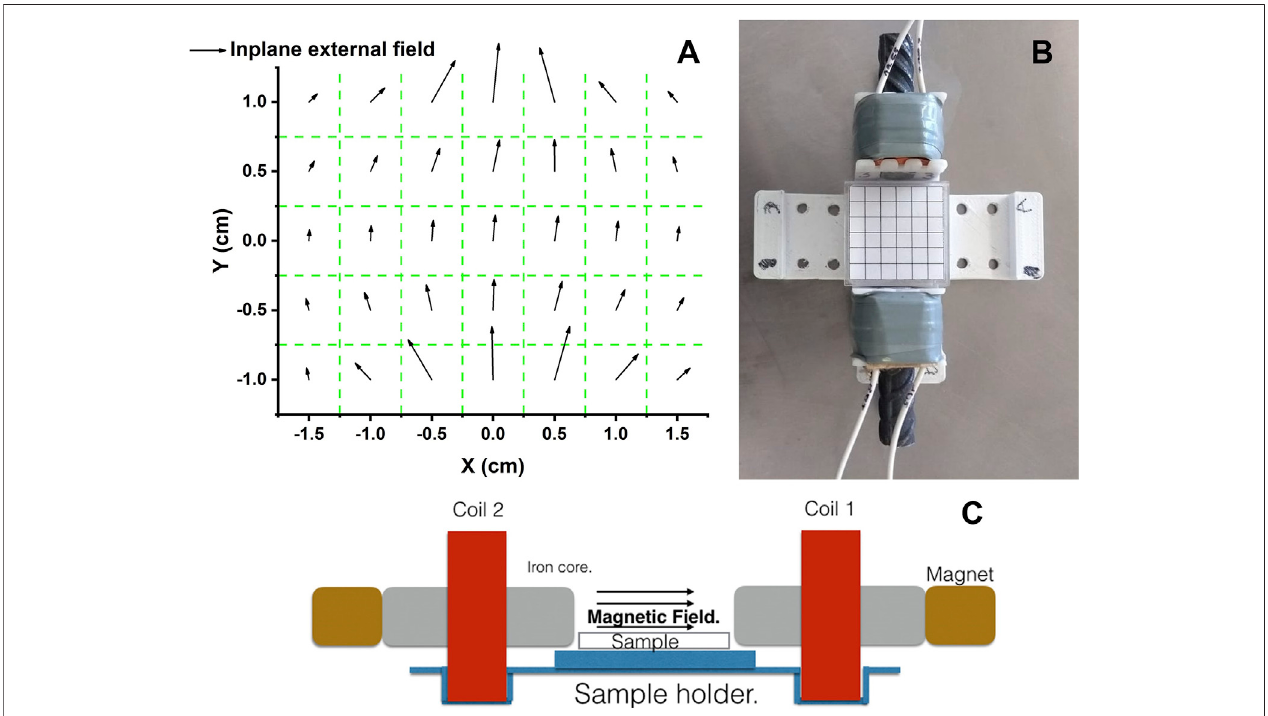
FIGURE3| ExperimentalsetupfortheDCmagnetic fi eldchamber.Vectorialmapsofthein-plane fi eld(9 (cid:1) 7 % )mappedovertheworkingspaceisshownin (A) . (B) is a top view of the magnetic chamber. (C) is a schematic representation of a side view of the experimental set up.